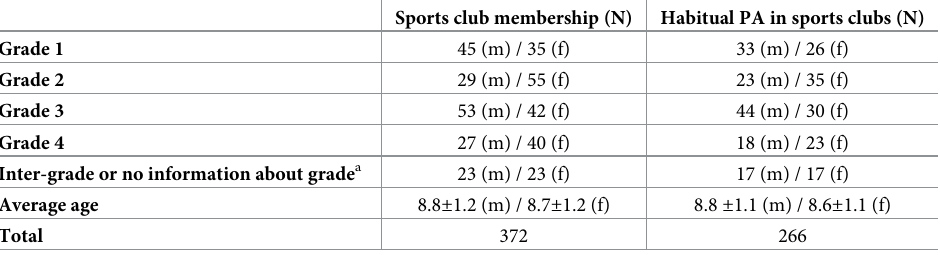
Table 1. Sample sizes.